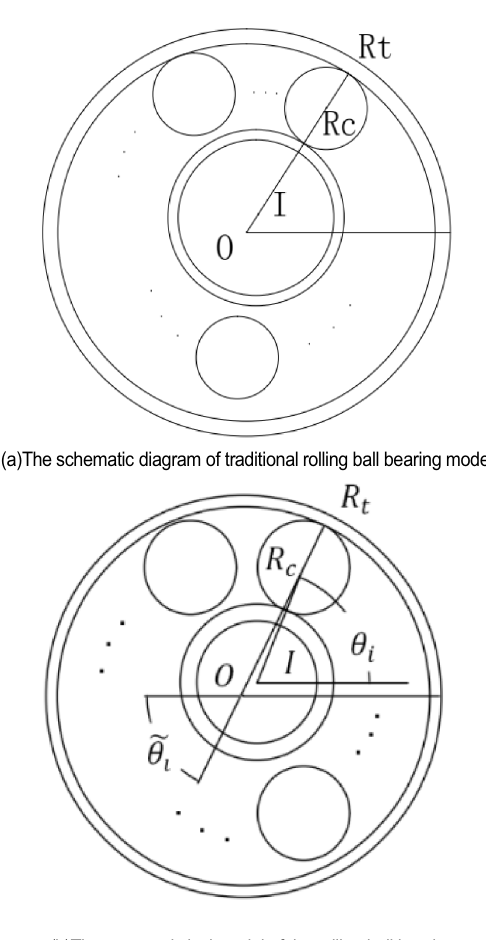
Fig. 1 Comparison of traditional analytical model with improved model; a the traditional model based on hypothesis that the center of the outer ring O, the center of the inner ring I and the contact point between the inner ring and the rolling ball R t are collinear; b the improved analytical model which is not based on the hypoth- esis and is more general and accurate than ( a ); there is main dif- ference: ̃𝜃 i and 𝜃 i between the improved model and the troditional model